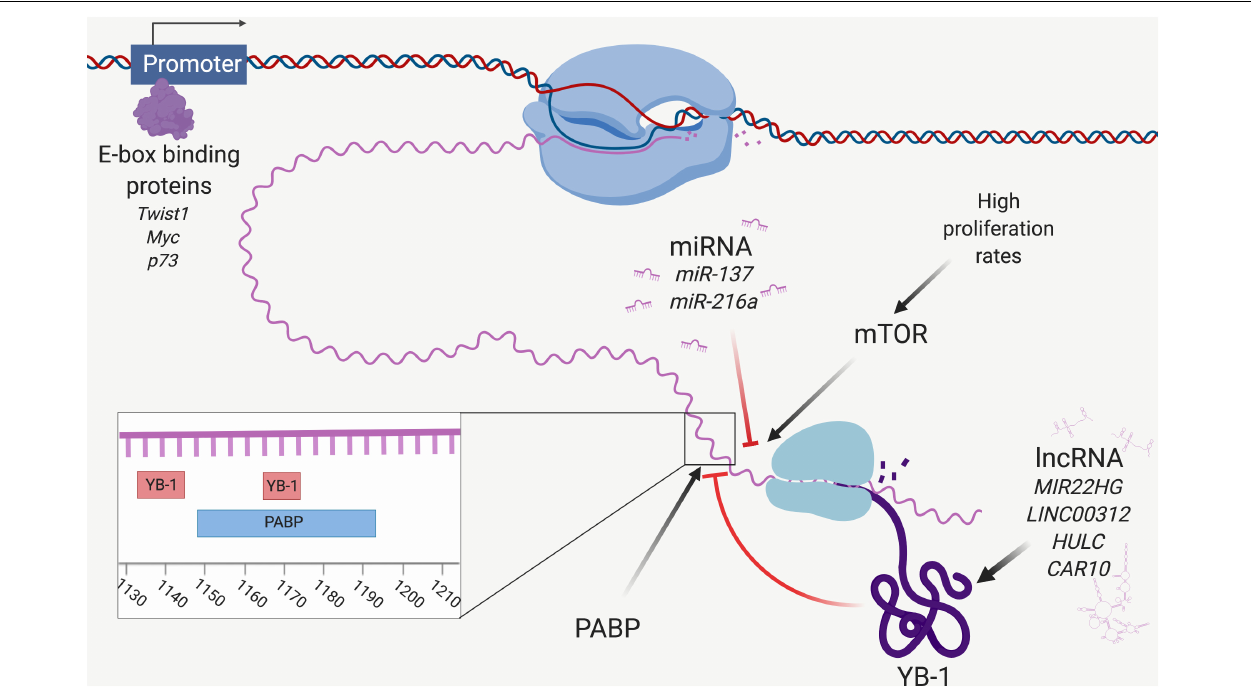
FIGURE 2 | Control of YB-1 expression. A network of factors controls YBX1 expression at the transcriptional and translational levels. The E-box binding proteins Twist1, Myc and p73 interact with the promoter of YBX1 and initiate transcription of YBX1 mRNA. YBX1 mRNA expression is downregulated by targeting miRNA, including miR-137 and miR-216a. YBX1 translation is stimulated by mTOR, which itself is influenced by proliferation rate. YB-1 protein function and expression are modulated by lncRNA, including MIR22HG and LINC00312. YB-1 is involved in an autoregulatory feedback loop and binds to YBX1 mRNA at two sites (nucleotides 1133–1145 and 1165–1172), inhibiting its own translation. PABP stimulates YBX1 translation by binding to a site located at 1149–1196, overlapping the second YB-1 binding site. Poly(A)-binding protein (PABP) and YB-1 compete for this site and hence regulate the level of YB-1 protein expression. Created with